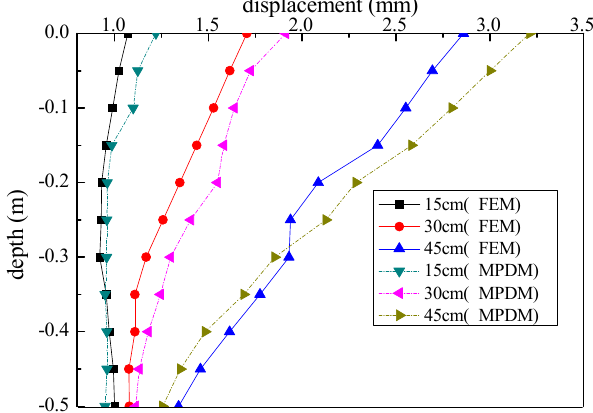
Figure 13. The results of the displacement calculated by the FEM and the results of the MPDM monitored.